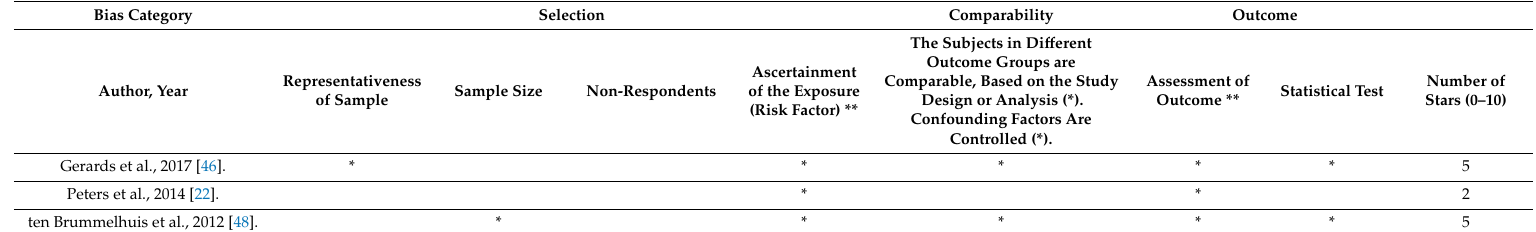
Table 7. Assessment of risk of bias for cross-sectional studies.